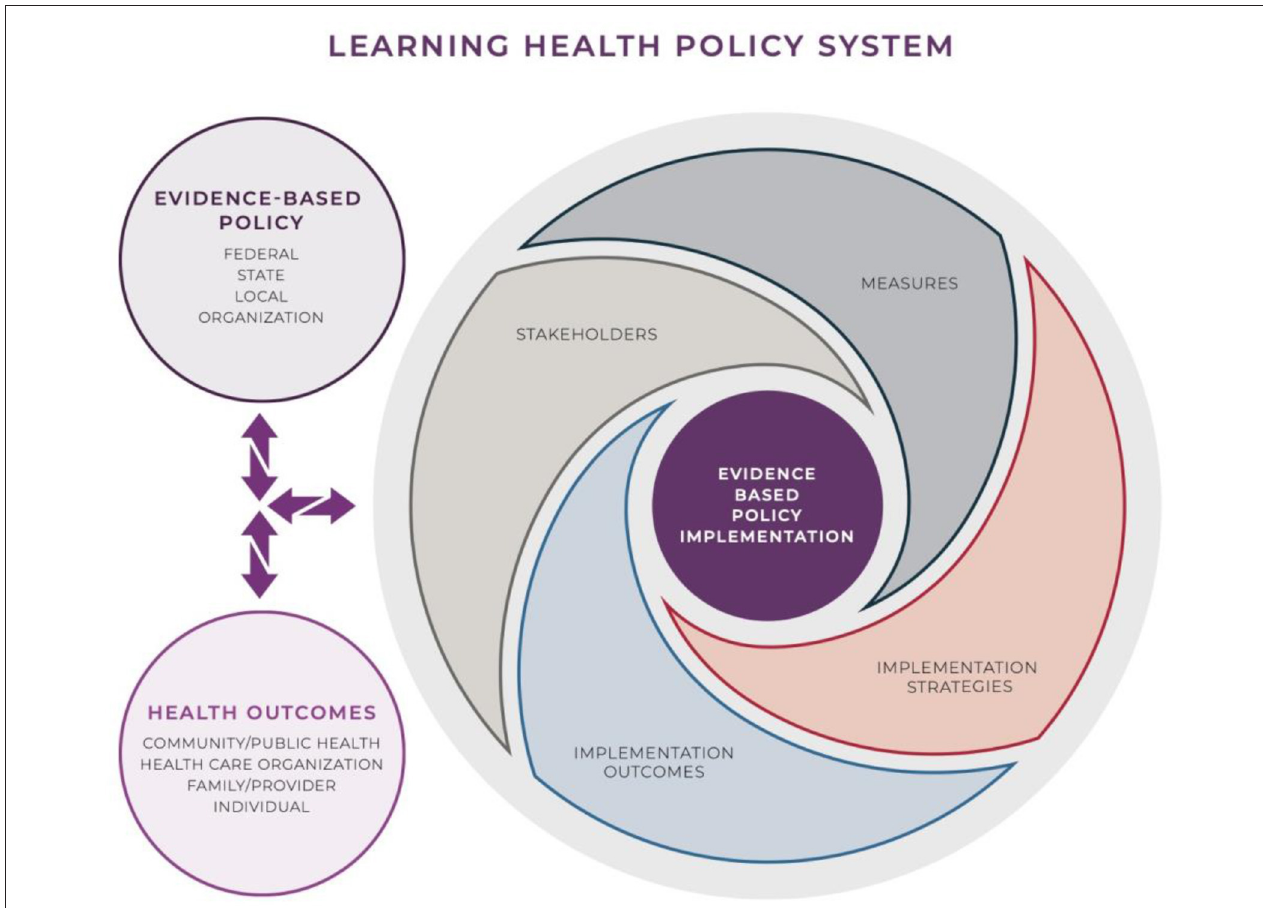
FIGURE 1 | Learning health policy